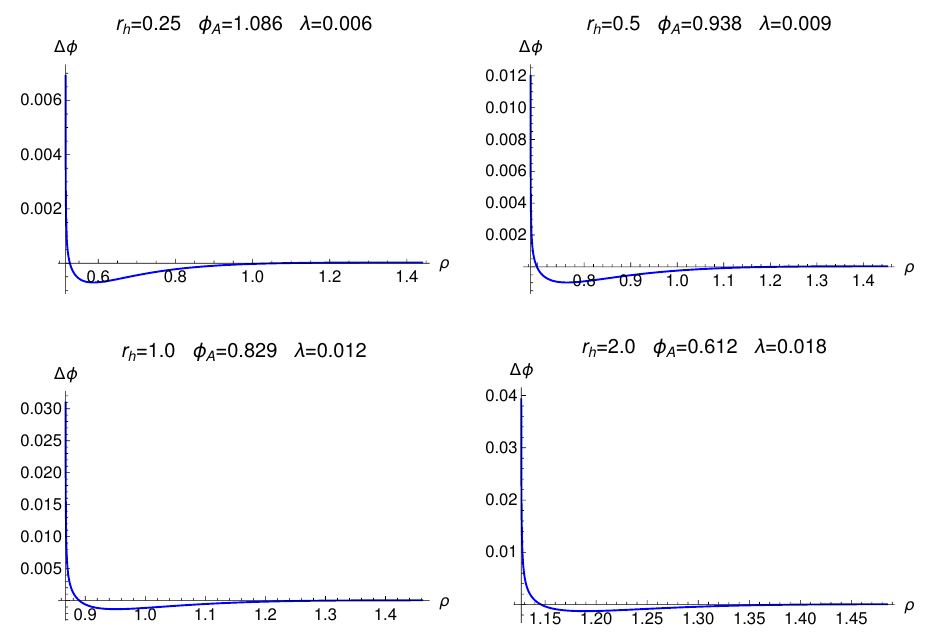
Figure 10. Angular di(cid:11)erence (cid:1) (cid:30) = (cid:30) E (cid:0) (cid:30) C between the entanglement minimal surface (cid:0) A , described by the curve (cid:30) E ( (cid:26) ), and the causal information surface (cid:4) A , described by the curve (cid:30) C ( (cid:26) ). The regions where (cid:1) (cid:30) < 0 indicate a violation of the CWI property, i.e., for certain choices of parameters ( r h ; (cid:21) ) we are able to (cid:12)nd a region A such that C ( A ) 6(cid:26) E ( A ).